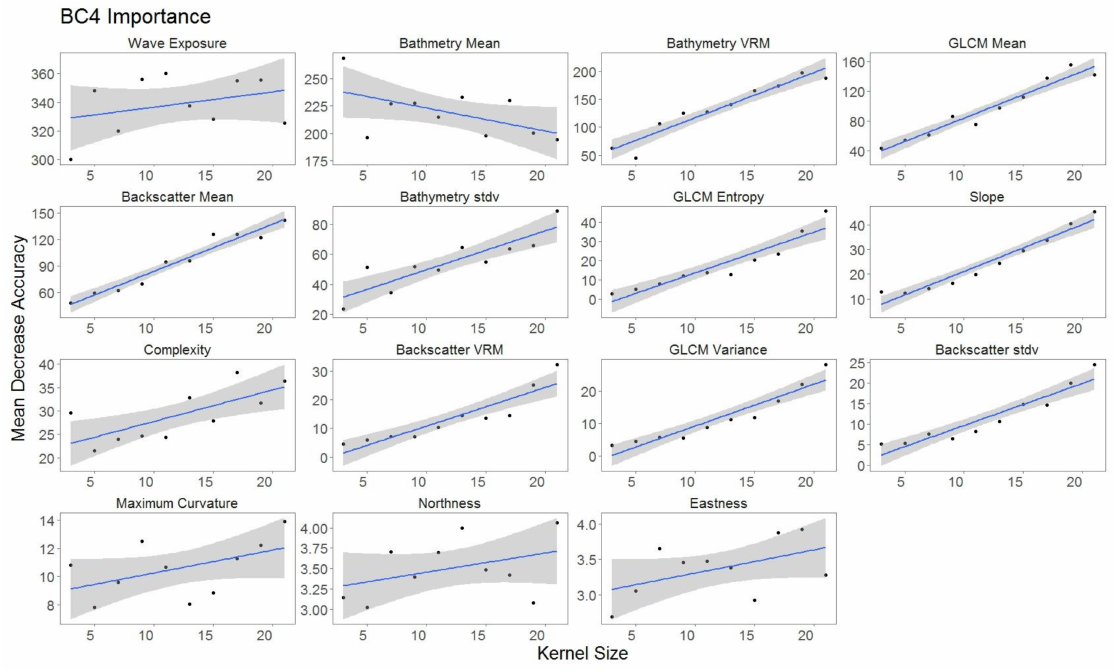
Figure A3. Variable importance BC4 sorted by derivatives in order of importance. GLM trend represented in blue. Gray area represents 95% confidence interval for